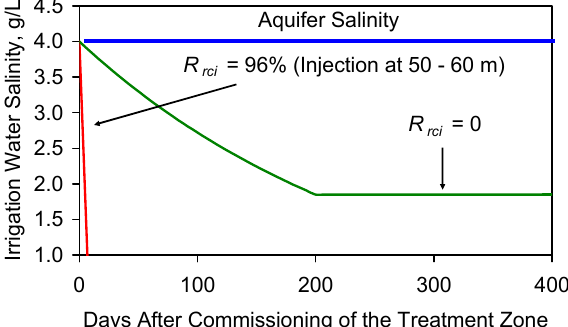
Figure F4. Change in salinity of the irrigation water abstracted from the modeled Aquifer Treatment Zone with time. Aquifer salinity = 4 g/L. R rci = Reinjection ratio = 480/500. Assumptions: (i) No Injection; n = 0 m 3 · day − 1 . Leakage = 0%; (ii) Injection at 50–60 m from the abstraction well; n = 0 m 3 · day − 1 ; Leakage = 0%; Aquifer thickness = 1 m.